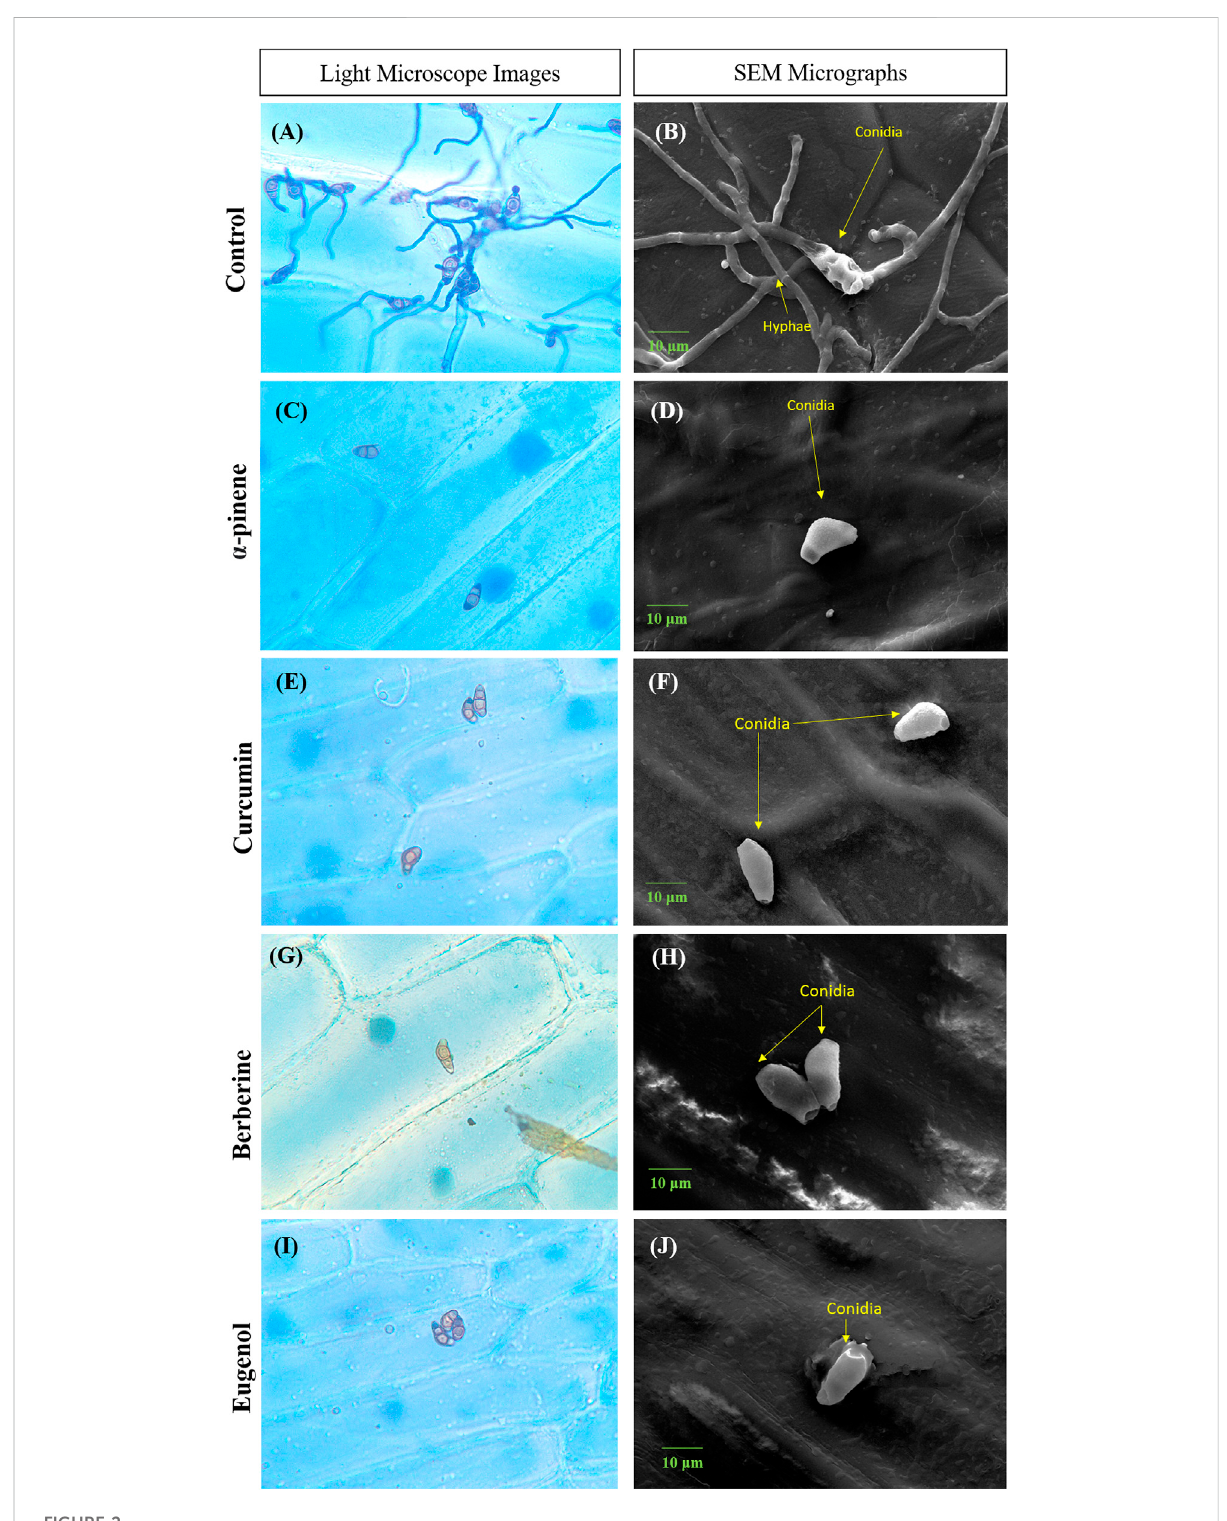
FIGURE 2 Microscopic images depicting conidia of C.lunata Control (A,B) ; α -pinene (C,D) ; curcumin (E,F) ; berberine (G,H) ; and eugenol (I,J) . Scale bar = 10